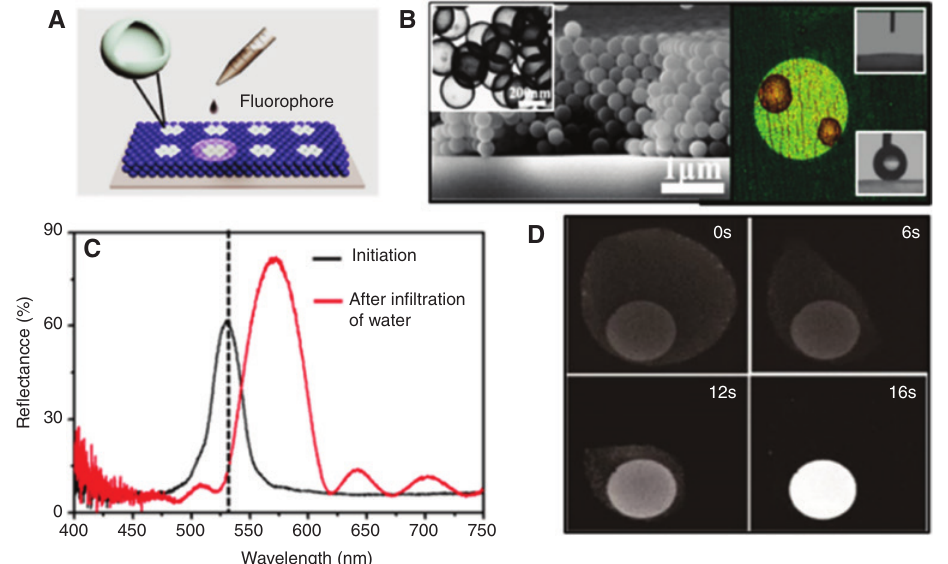
Figure 7: Fabrication of patterned HSCPCs for real-time fluorescence detection. (A) Schematic illustration of the superhydrophobic hollow sphere CPCs with superhydrophilic patterns. (B) The structural properties of the patterned hollow sphere CPCs. (C) The optical properties of the superhydrophilic region of the patterned sample before and after infiltra- tion of water. (D) Fluorescence images sequences of enrichment process on the patterned HSCPCs. Adapted with permission from ref. [34], COPYRIGHT 2017 American Chemical